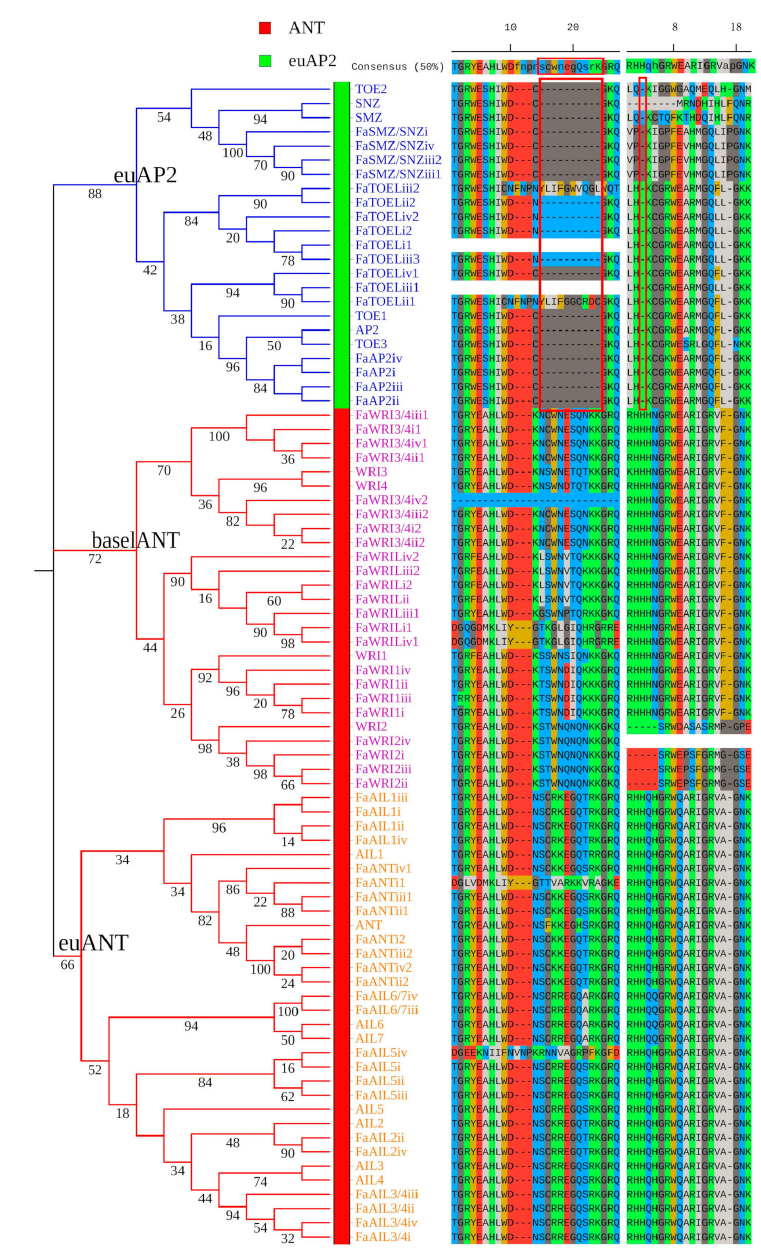
Figure 1. The maximum-likelihood (ML) phylogeny of APETALA2 (AP2) transcription factors of Fragaria × ananassa (FaAP2) and Arabidopsis thaliana . AINTEGUMENTA (ANT) and euAP2 lineages are indicated with green and red strips, respectively. The euAP2, baselANT, and euANT groups are distinguished by blue, pink, and yellow gene label colors, respectively. Numbers on branches are bootstrap values. Alignments of the insertion part of the AP2 domain repeat 1 and repeat 2 indicate the absent motifs of the euAP2 lineage underlined with red